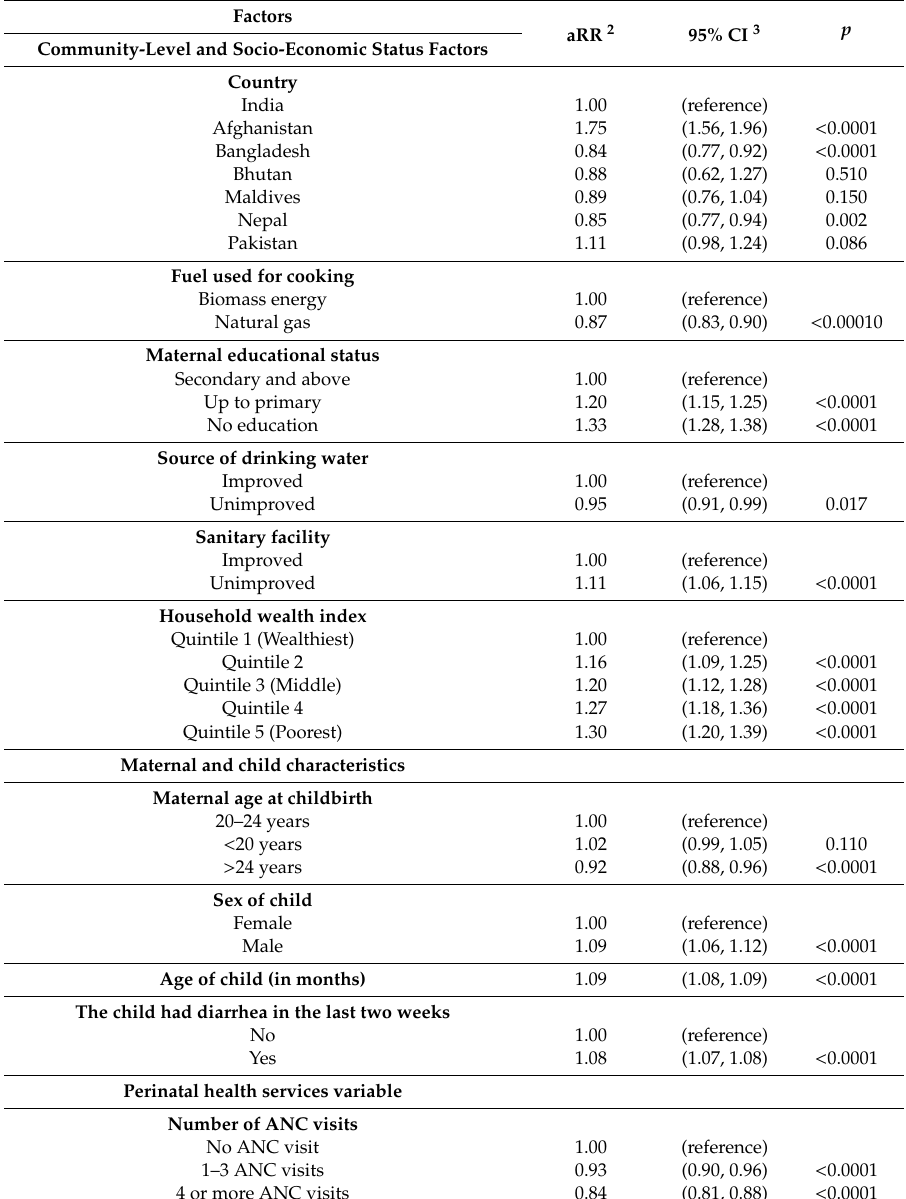
Table 5. Factors associated with stunting (LAZ < − 2) in South Asian children < 2 years old (2005–2016): Results of adjusted Poisson regression 1